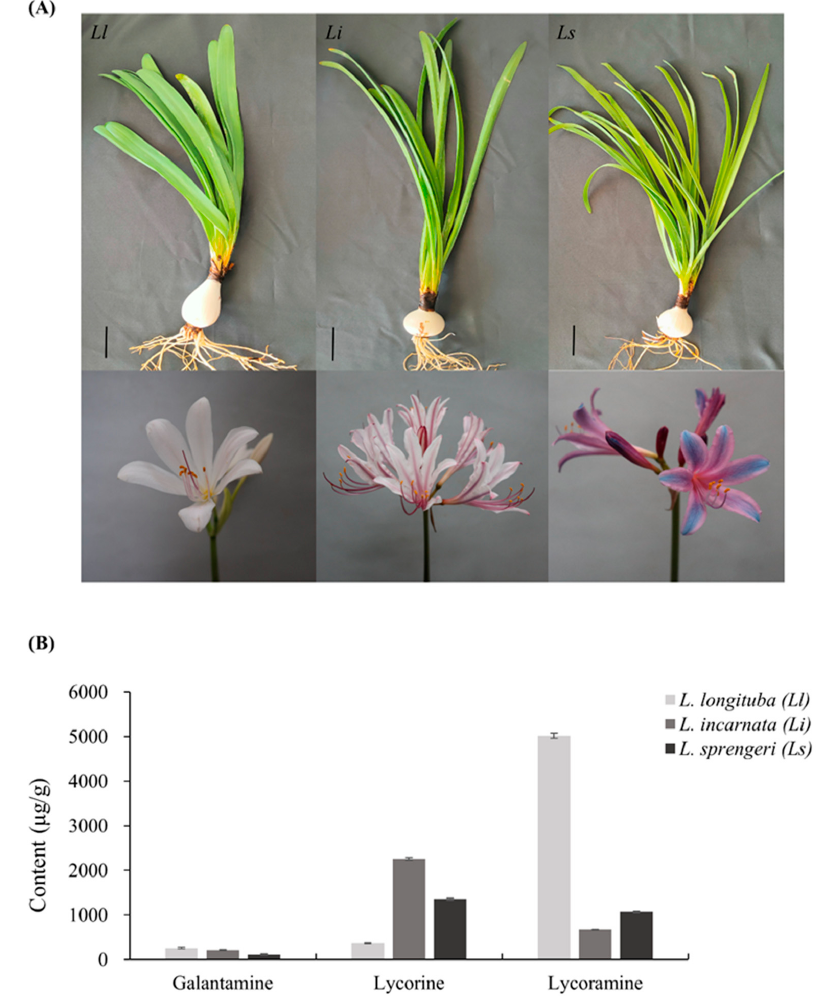
Figure 1. Phenotype of samples and alkaloid contents of three kinds of Lycoris species. ( A ) The three kinds of plant materials: Lycoris longituba , Lycoris incarnata , and Lycoris sprengeri . They were collected from the Institute of Botany, Chinese Academy of Sciences, Jiangsu Province, China (32.05 ◦ N, 118.83 ◦ E) in late March when the leaves were growing vigorously (Bars = 3 cm). ( B ) The total content of three alkaloids in Lycoris longituba was the highest, whereas that in Lycoris sprengeri was the